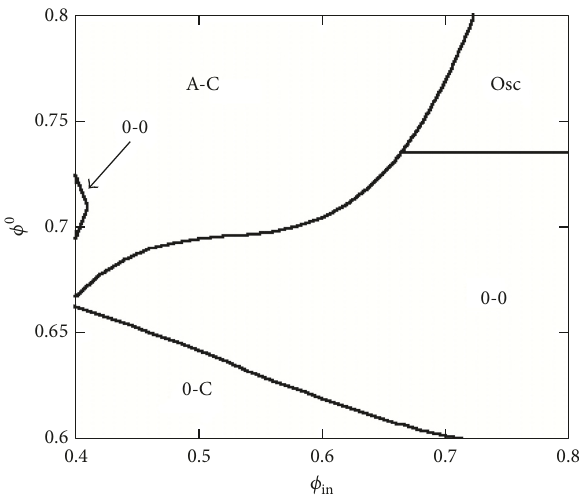
Figure 6: Phase diagram in ( 𝜙 in , 𝜙 0 ) parameter space for scenario A. The corresponding attractors are denoted by their steady state characteristic (0-0, A-C, 0-C) or their oscillatory behaviour (Osc).